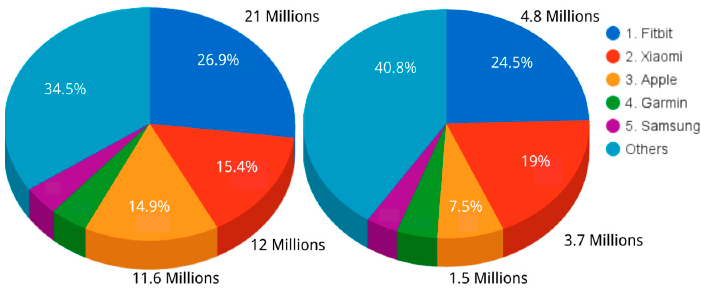
Figure 1. Wrist wearable devices’ 2015 market share on the left side, 1Q2016 market share on the right side, both by IDC Research Inc. (Framingham, MA, USA) (Adapted from [30,31]).